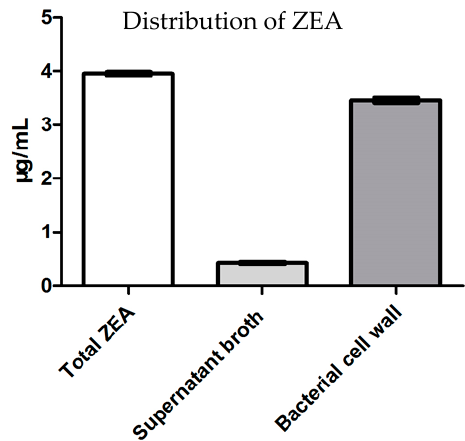
Figure 2. The contents of ZEA in supernatant and cell precipitate after the xy46 strain was anaerobically co-cultured with ZEA at 37 °C using a 120 rpm/min shaker for 24 h. The experiments are averages of three replicates.